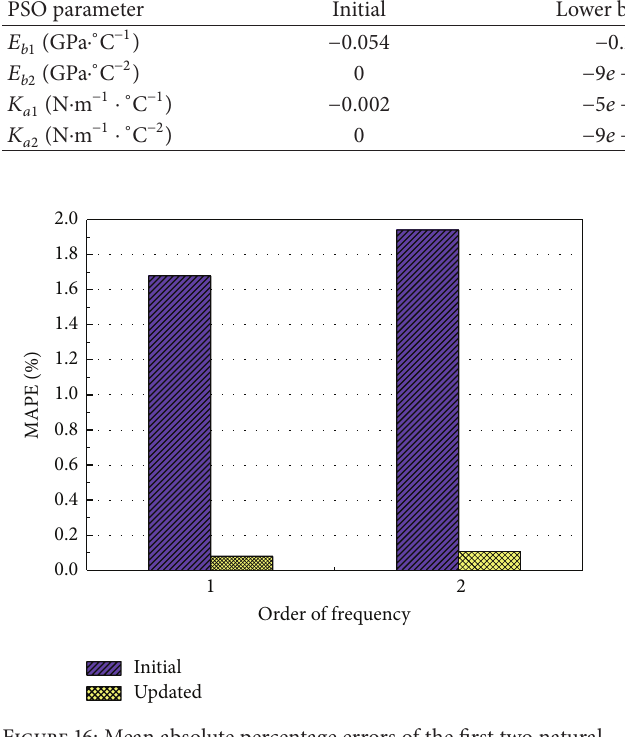
Figure 16: Mean absolute percentage errors of the first two natural frequencies.